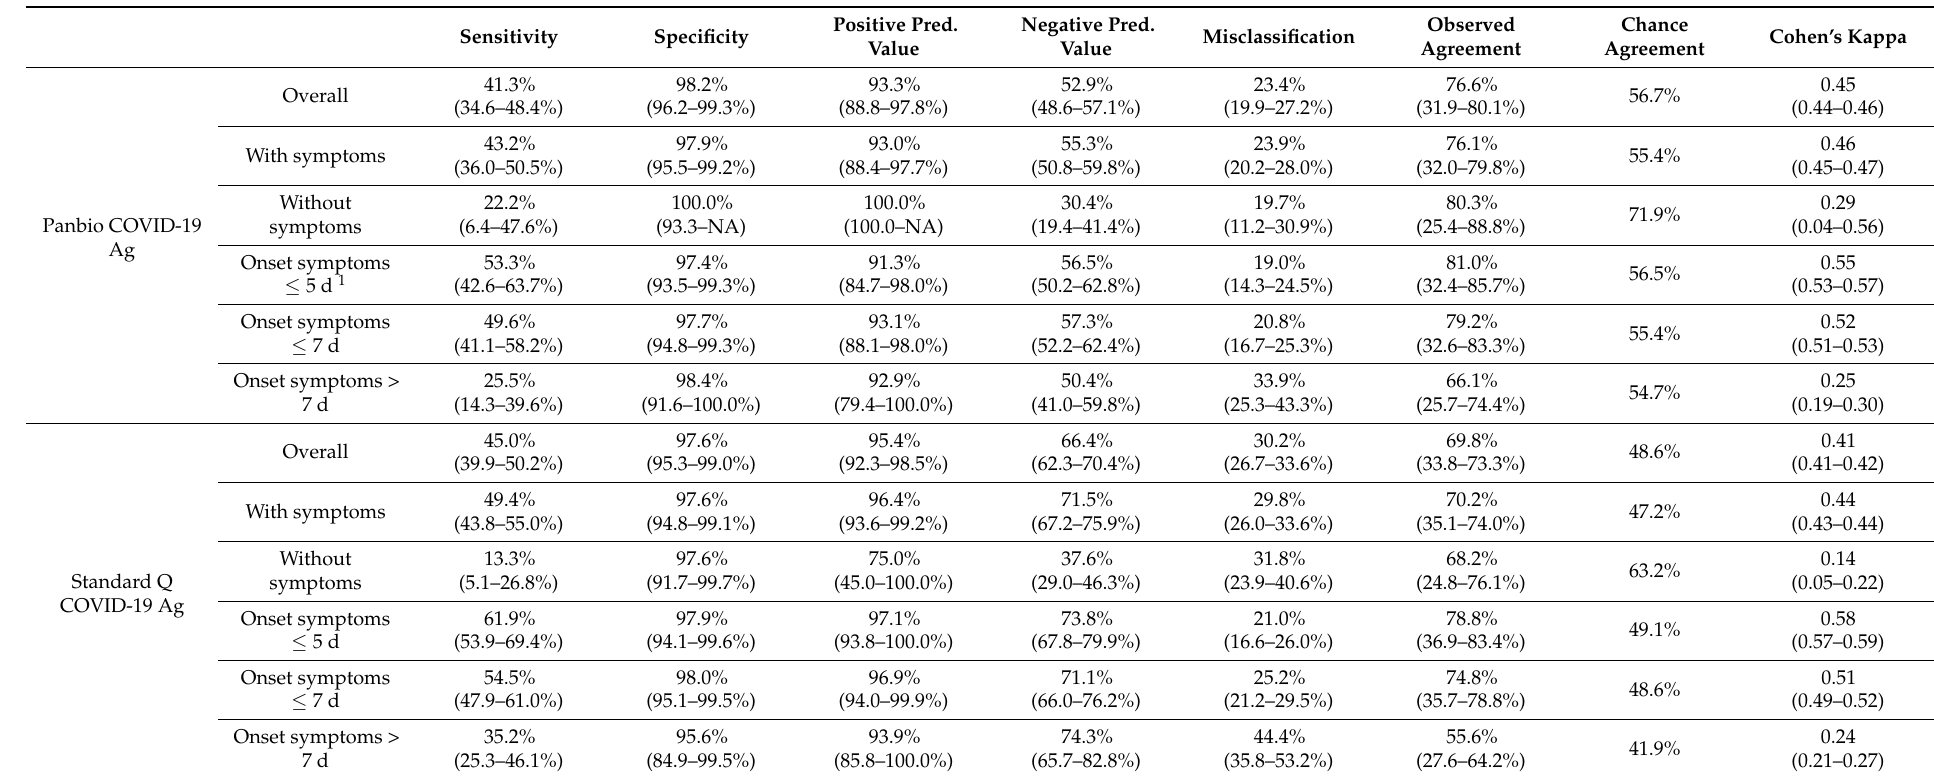
Table 2. Analytic performance of two antigen rapid assays for SARS-CoV-2